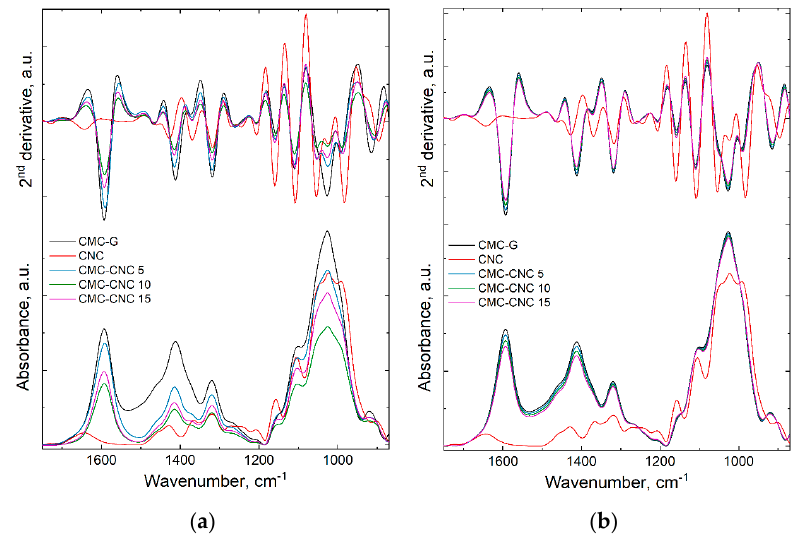
Figure 3. Experimental ( a ) and theoretic ( b ) infrared spectra and their second derivatives in the 1750–870 cm − 1 region of the components and nanocomposites.